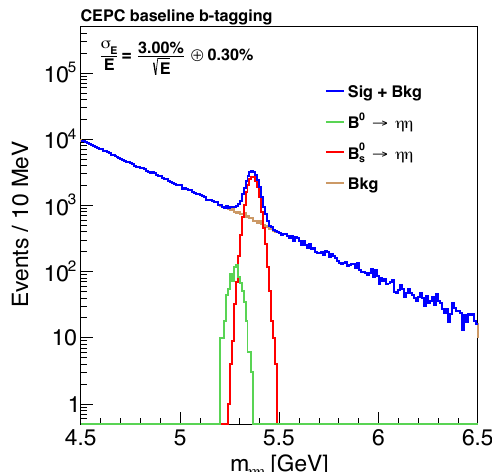
Figure 8 . The reconstructed m ηη distributions of B 0 → ηη , B 0 → ηη , and Z → q ¯ q background s after applying the baseline b -tagging and selections on energy and opening angle of η pairs when the ECAL energy resolution is 3% √ ⊕ 0 . 3% E